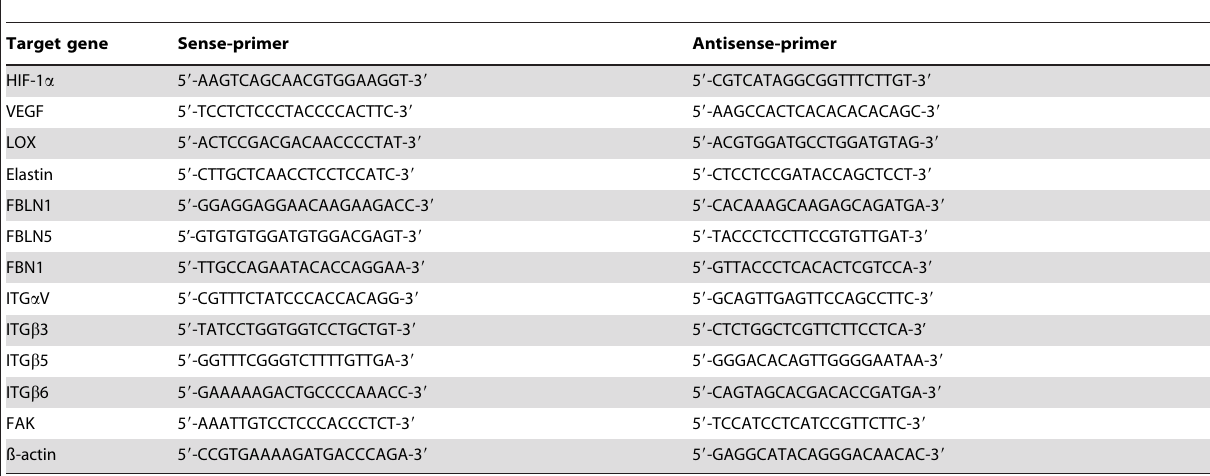
Table 1. Primer sequences used for real-time quantitative